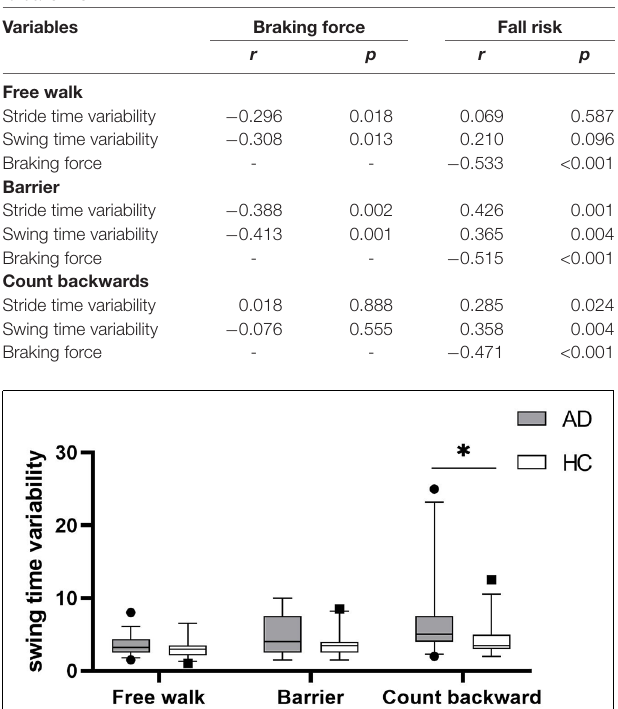
TABLE 3 | Pearson correlation between gait parameters and braking force/fall risk.